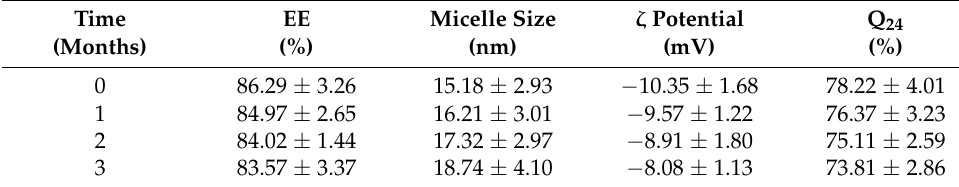
Table 6. Storage stability of